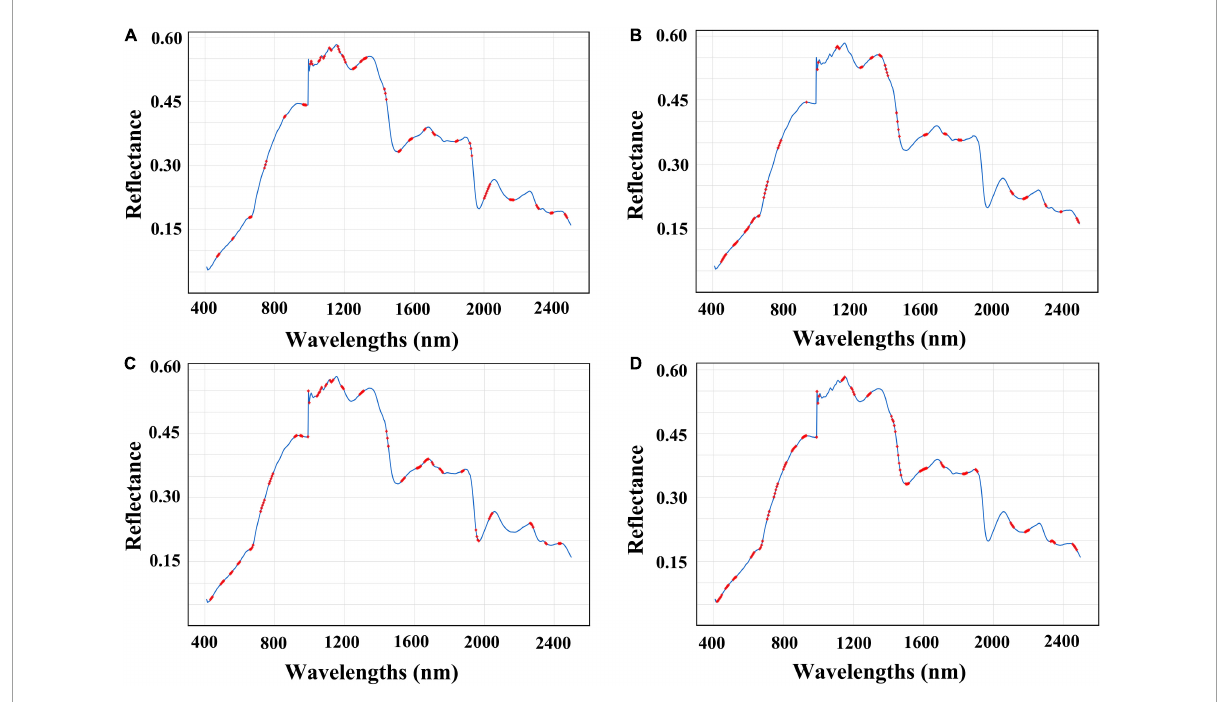
FIGURE3 Selected wavelengths for best prediction in nutrient contents of RRB fruits. The selected wavelengths are shown in red dots. (A) Selected wavelengths in PPS prediction (CARS-ORI-PLSR); (B) selected wavelengths in RS prediction (CARS-MSC-PLSR); (C) selected wavelengths in TF prediction (VISSA-DER-PLSR); (D) selected wavelengths in TP prediction